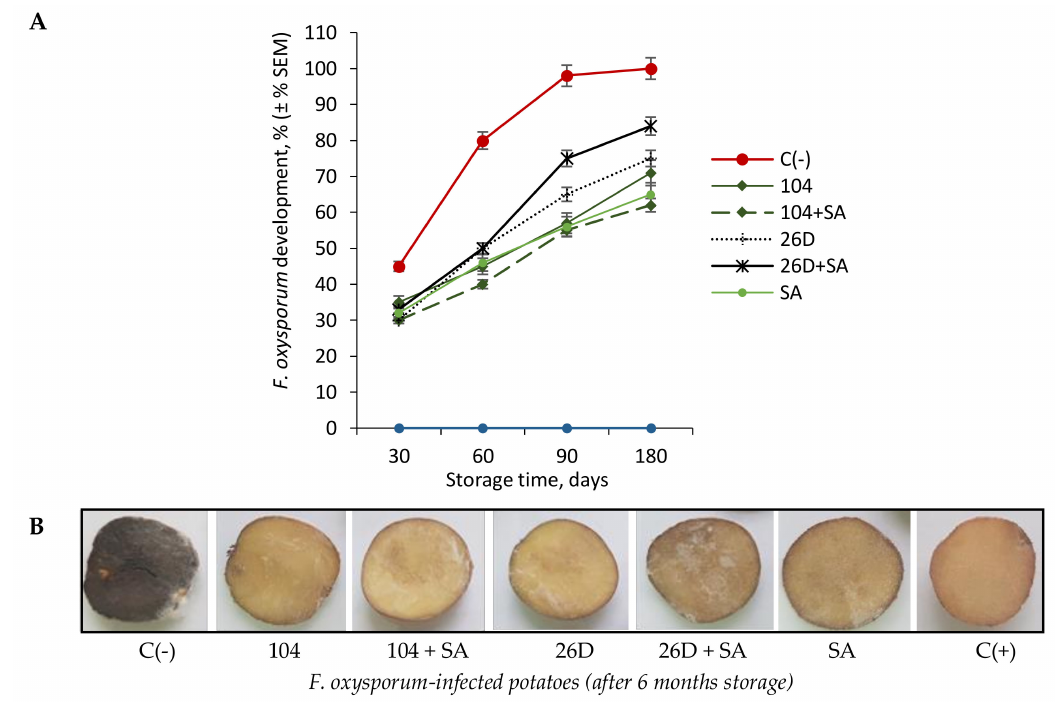
Figure 1. E ff ect of B. subtilis 10-4 (104), B. subtilis 26D (26D), B. subtilis 10-4 + salicylic acid (SA) (104 + SA), and B. subtilis 26D + SA (26D + SA) on F. oxysporum development in potatoes during long-time storage for six months ( A ) and pictures of tubers stored six months after infestation with F. oxysporum and coated with B. subtilis strains 10-4, 26D, and their compositions with SA ( B ). For each treatment was used 30 mini-tubers in three replicates ( ± SEM). C(-)—negative control tubers infected before storage with F. oxysporum ; 104—tubers infected with F. oxysporum and treated with B. subtilis 10-4; 104 + SA—tubers infected with F. oxysporum and treated with composition B. subtilis 10-4 + SA; 26D—tubers infected with F. oxysporum and treated with B. subtilis 26D; B. subtilis 26D + SA—tubers infected with F. oxysporum and treated with B. subtilis 26D + SA, SA—tubers infected before storage with F. oxysporum and treated with SA; C( + )—positive control tubers without infection and